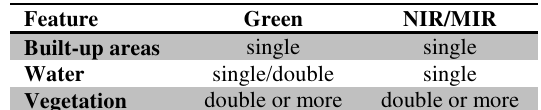
Table 3. Recorded returns from different feature in green, NIR, and MIR channels